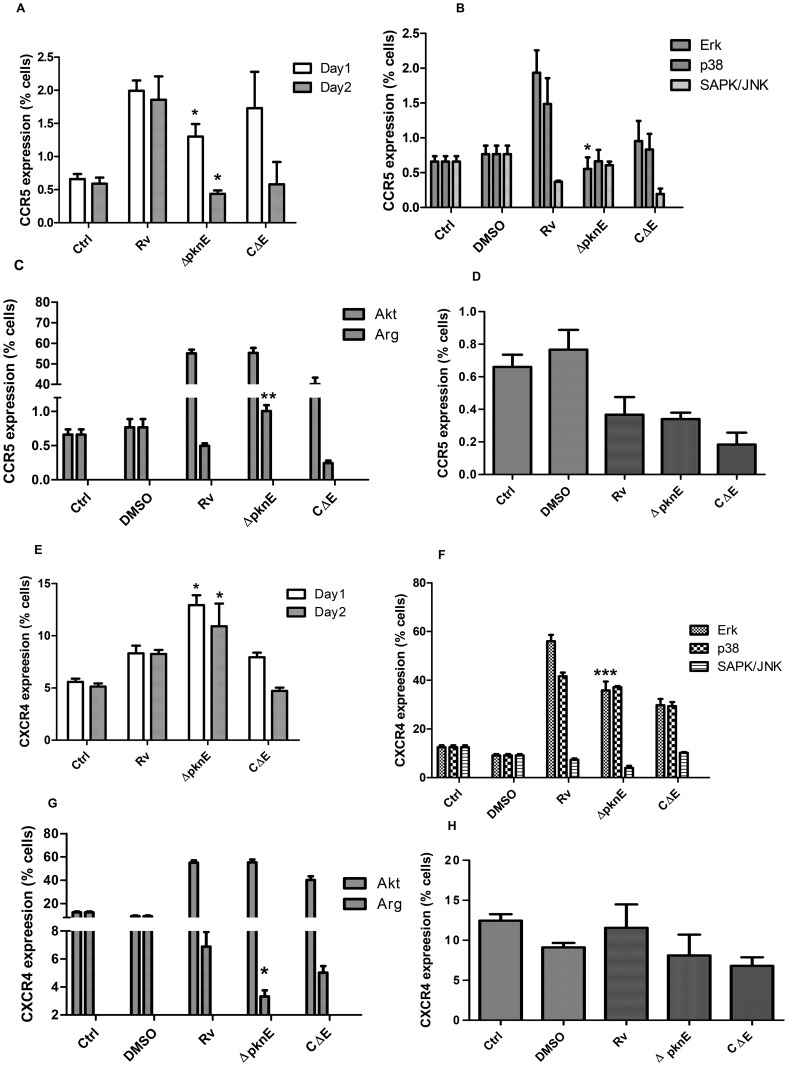
ΔpknE infected macrophages modulate the expression of coreceptors CCR5 and CXCR4 by intracellular cascades.Cells post infection were stained with CCR5 (A) and CXCR4 (E) antibody and the expression was analyzed in a time dependent manner using FACS, * denotes p<0.05 (Twoway – Anova) when ΔpknE was compared to Rv infected macrophages. Cells post infection in the presence of inhibitors CCR5 [B) MAPK family, C) survival family and D) TP53] and CXCR4 [F) MAPK family, G) survival family, and H) caspase family] expression was analyzed on day1 post infection using FACS. The symbols *, **, ***denotes p<0.05, p<0.001 and p<0.0001 respectively (one way – Anova) when ΔpknE was compared to Rv infected macrophages.